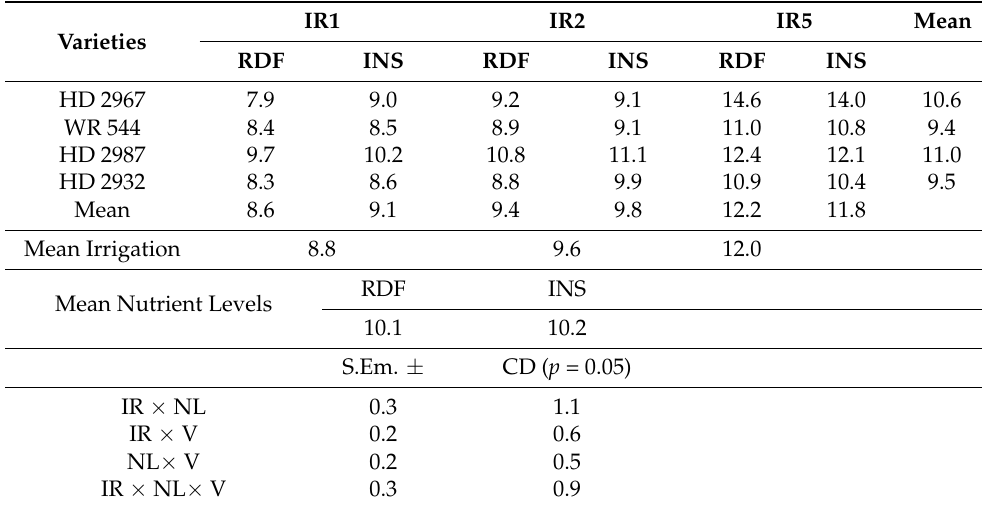
Table 4. Interaction effect of irrigation schedules, nutrient management levels, and varieties on total biomass yield (tons ha − 1